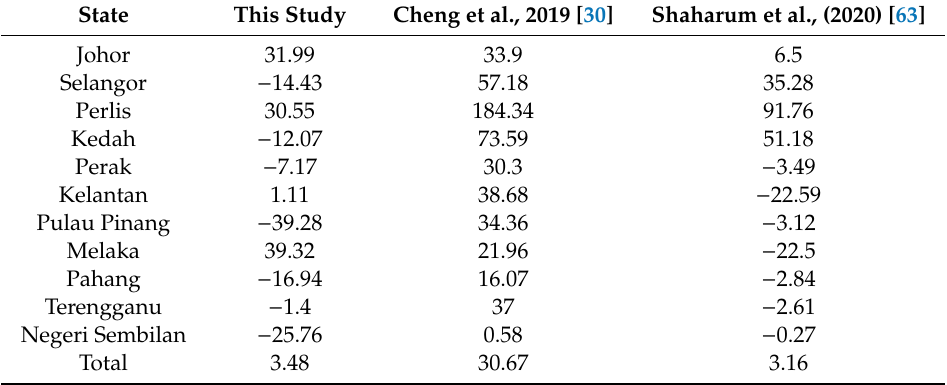
Table 8. Comparison of oil palm areas estimated in this study and other studies with that of MPOB statistics. Unit of the values is percentage (%) di ff erence calculated as: This study-MPOB) / ((This study + MPOB) /